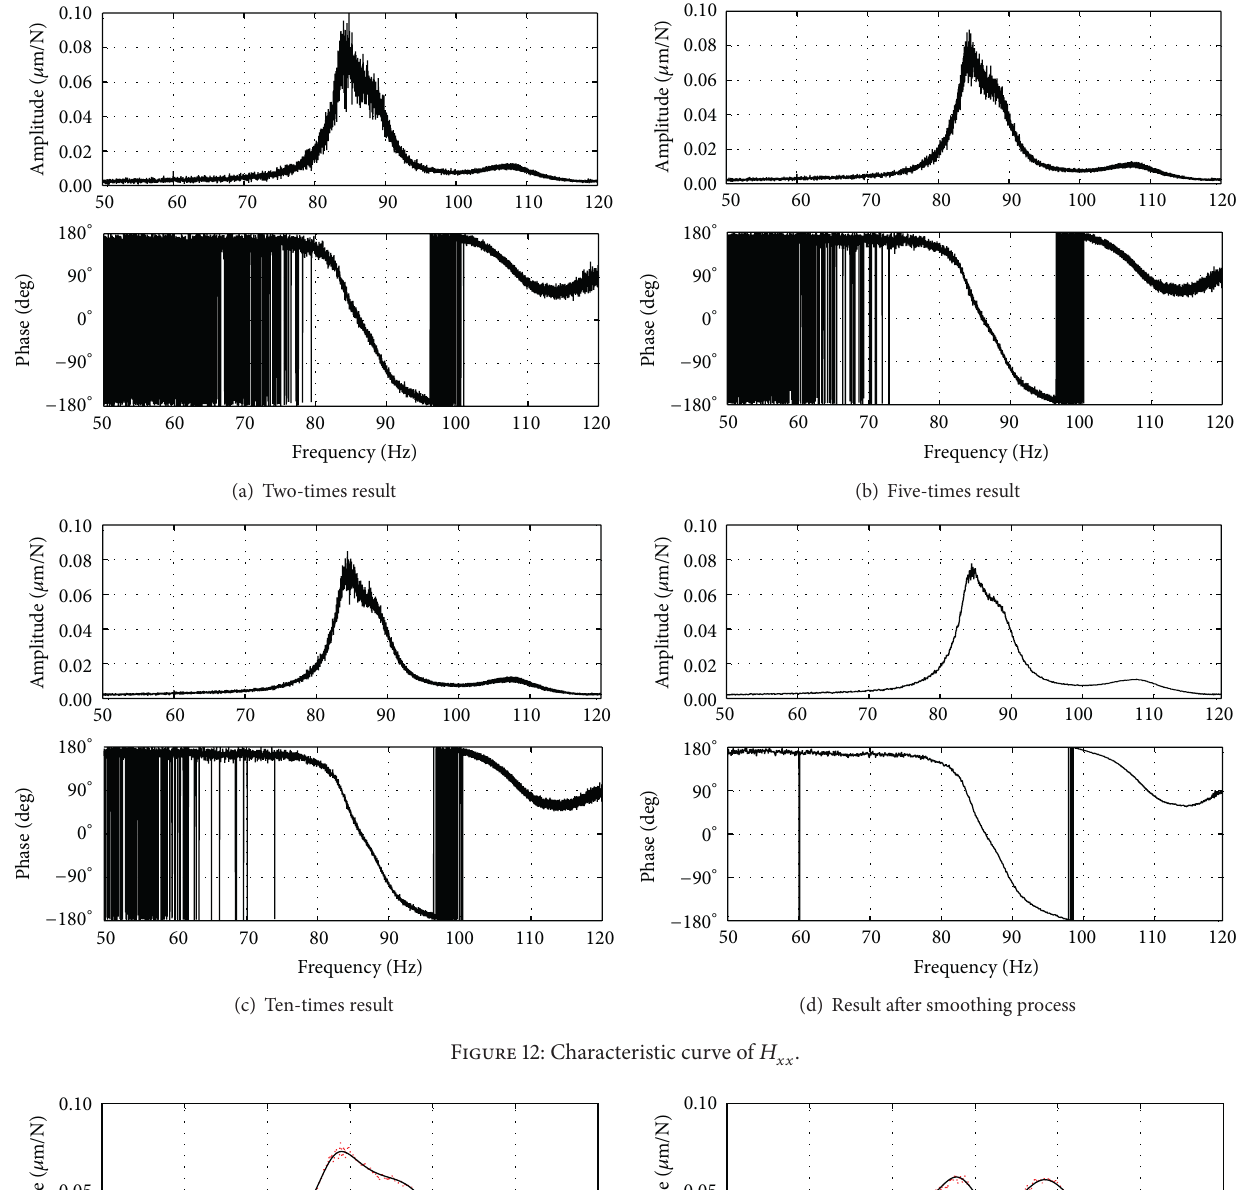
Figure 12: Characteristic curve of 𝐻 𝑥𝑥 .